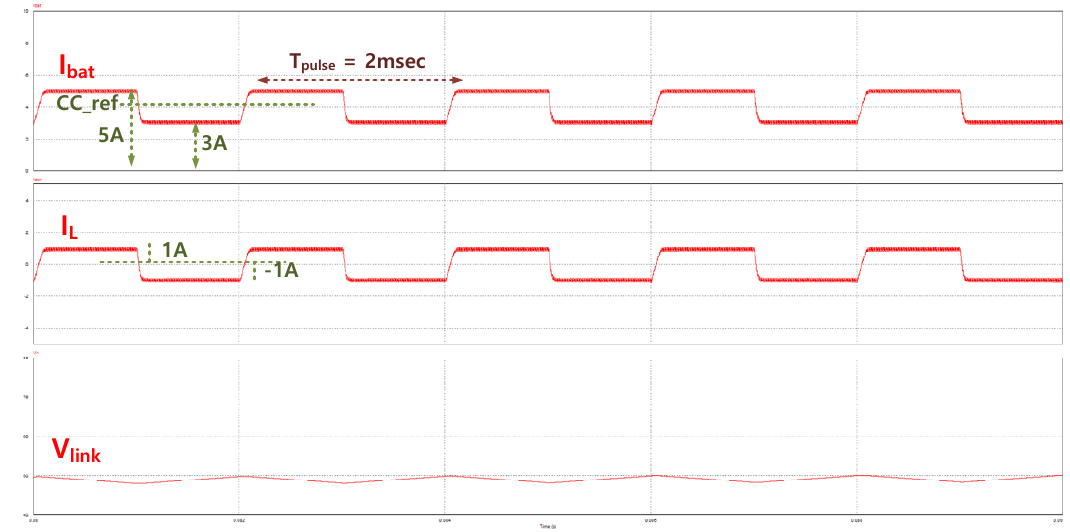
Electronics 2020 , 9 , 227 9 of 13 Figure 10. Results of the simulation at a 50% pulse duty ratio and 500 Hz pulse frequency.